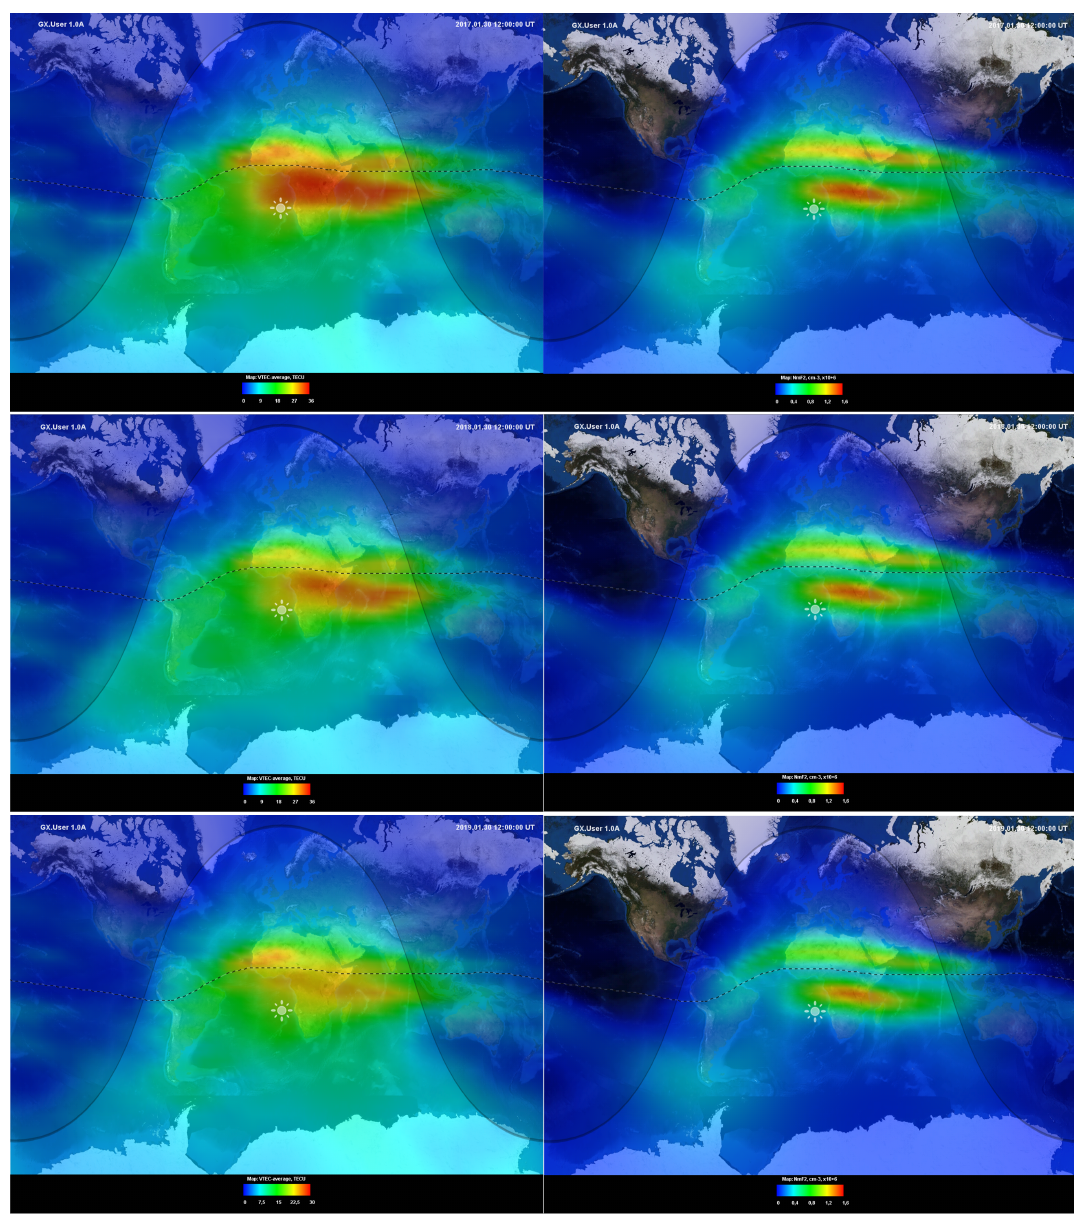
Figure 8. Climate VTEC ( left column) and climate NmF2 ( right column) at 12 UT on 30 January 2017 ( upper row), 2018 ( middle row) and 2019 ( bottom